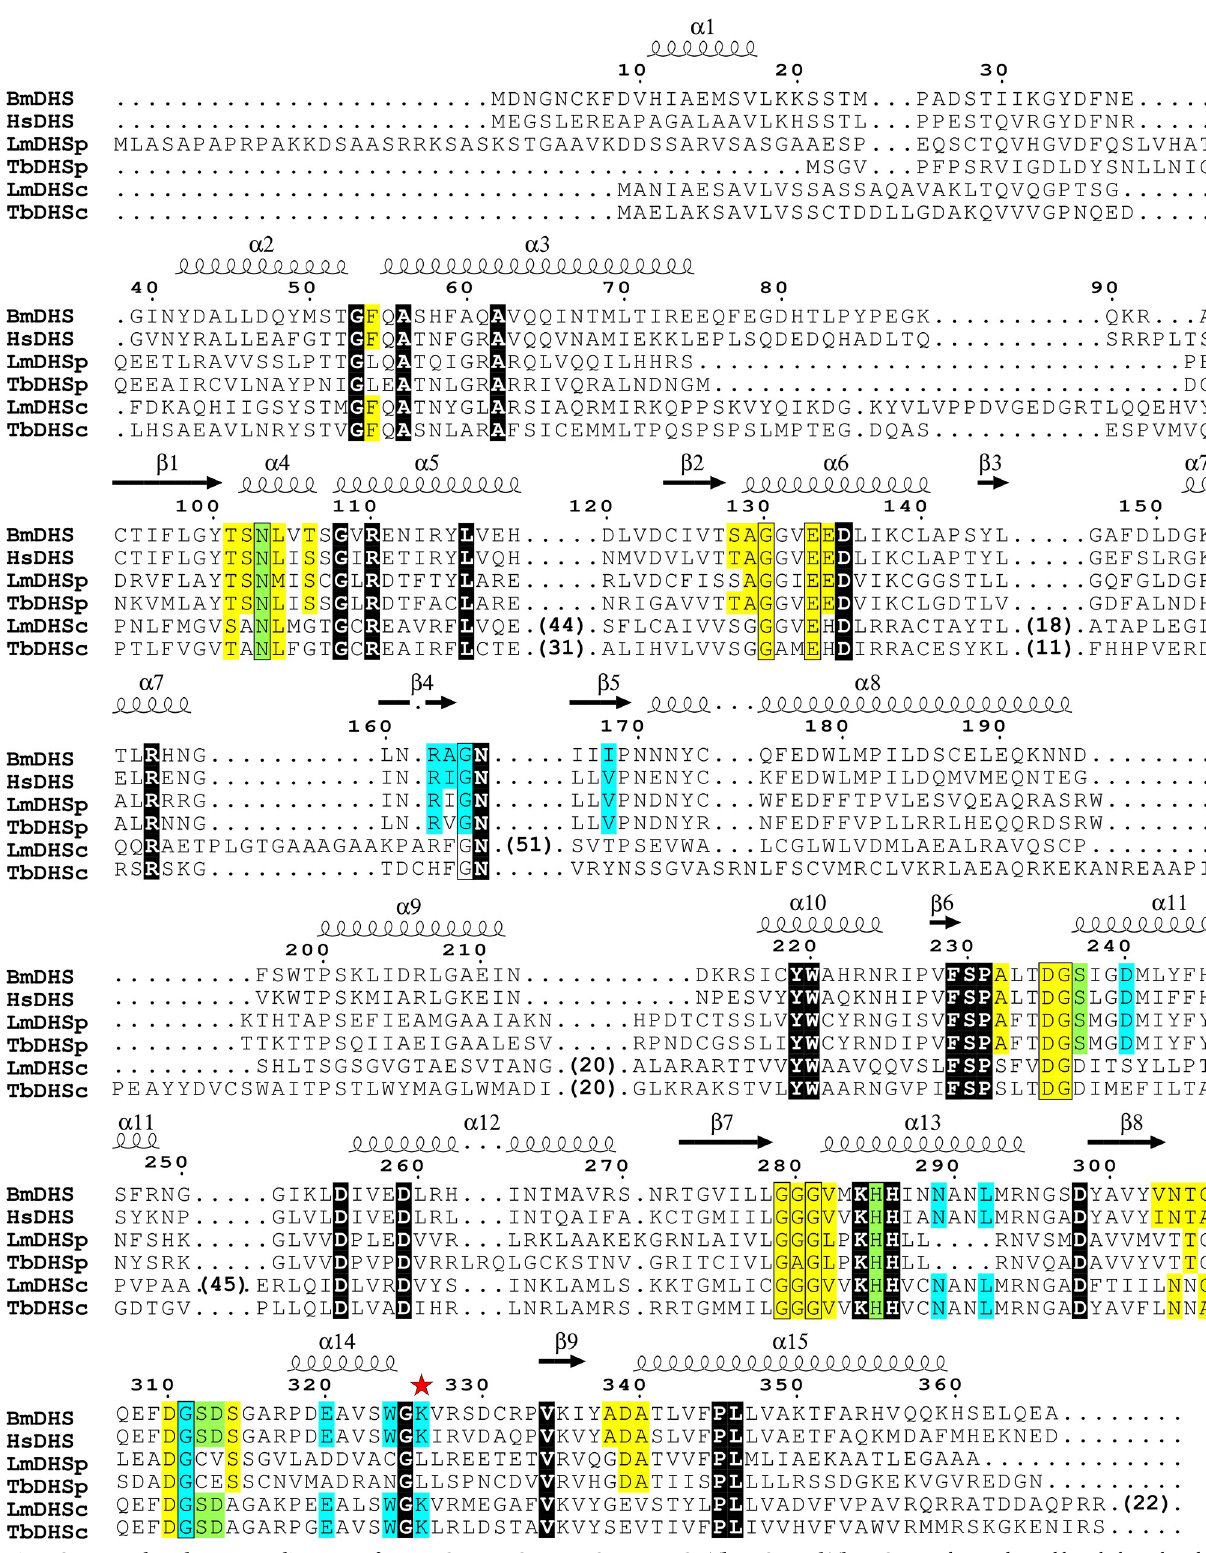
Fig 1. Structure-based sequence alignment of BmDHS, HsDHS, LmDHSp, LmDHSc, TbDHSp, and TbDHSc. Residues indicated by a light-colored background participate in binding to NAD + (yellow) spermidine/GC7 (blue), or both ligands (green). Background coloring for LmDHSp/DHSc